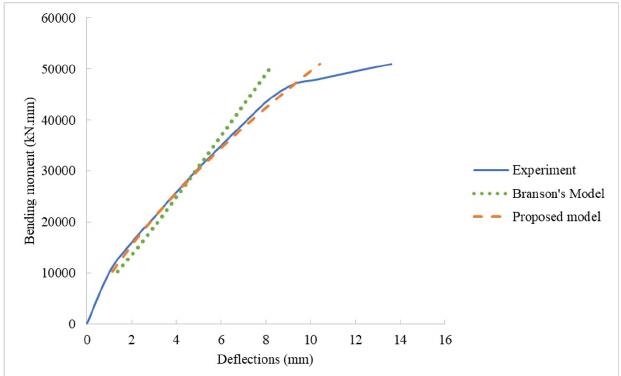
Figure 6. Experimental results from Álvares [31] compared with Branson’s model and the proposed model.